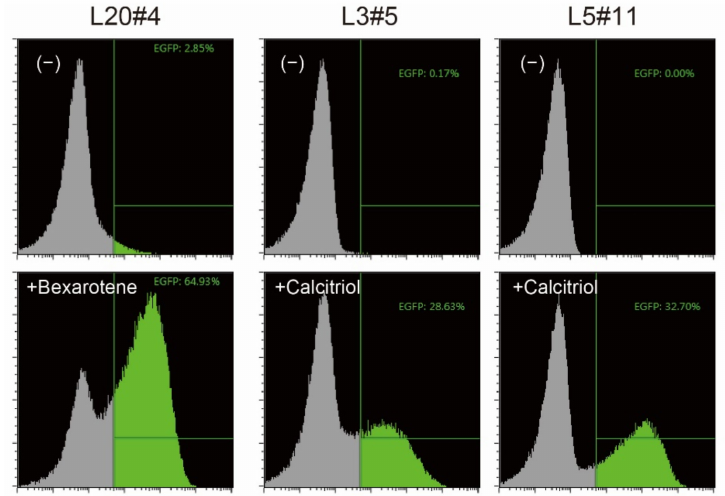
Figure 1. Confirmation of reporter cells. The isolated clones were treated without ( − ) or with the indicated vitamin compound for 18 h, and the expression of EGFP, one of the reporter proteins, was analyzed by flow cytometry. EGFP-positive cells are shown in